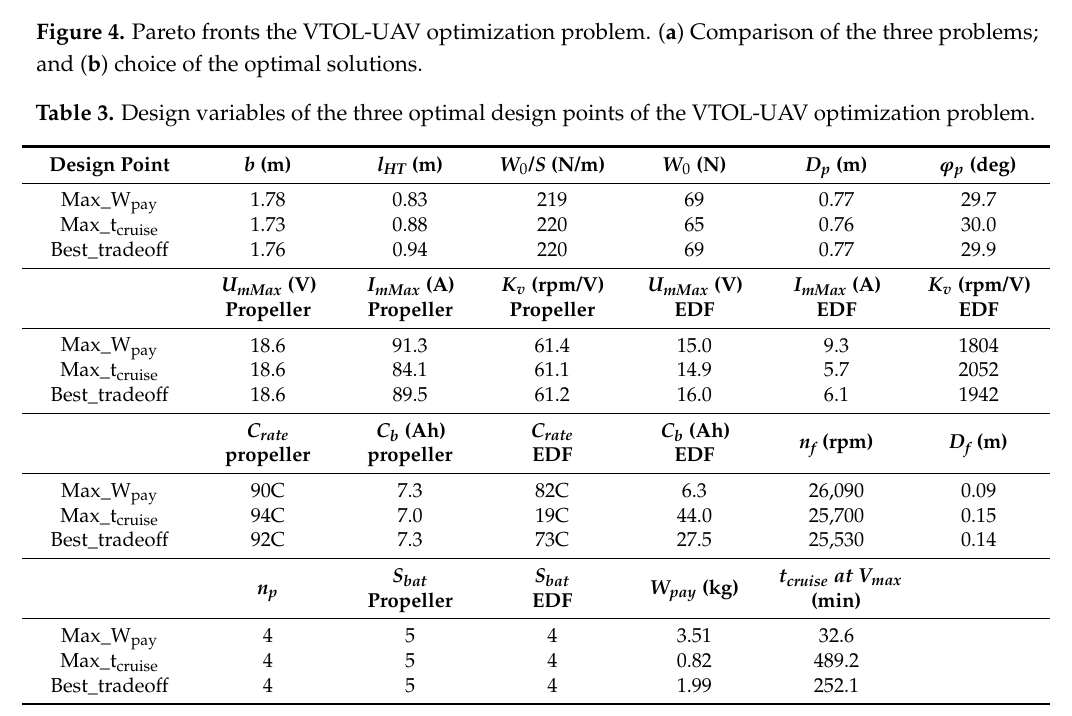
Table 3. Design variables of the three optimal design points of the VTOL-UAV optimization problem. Design Point